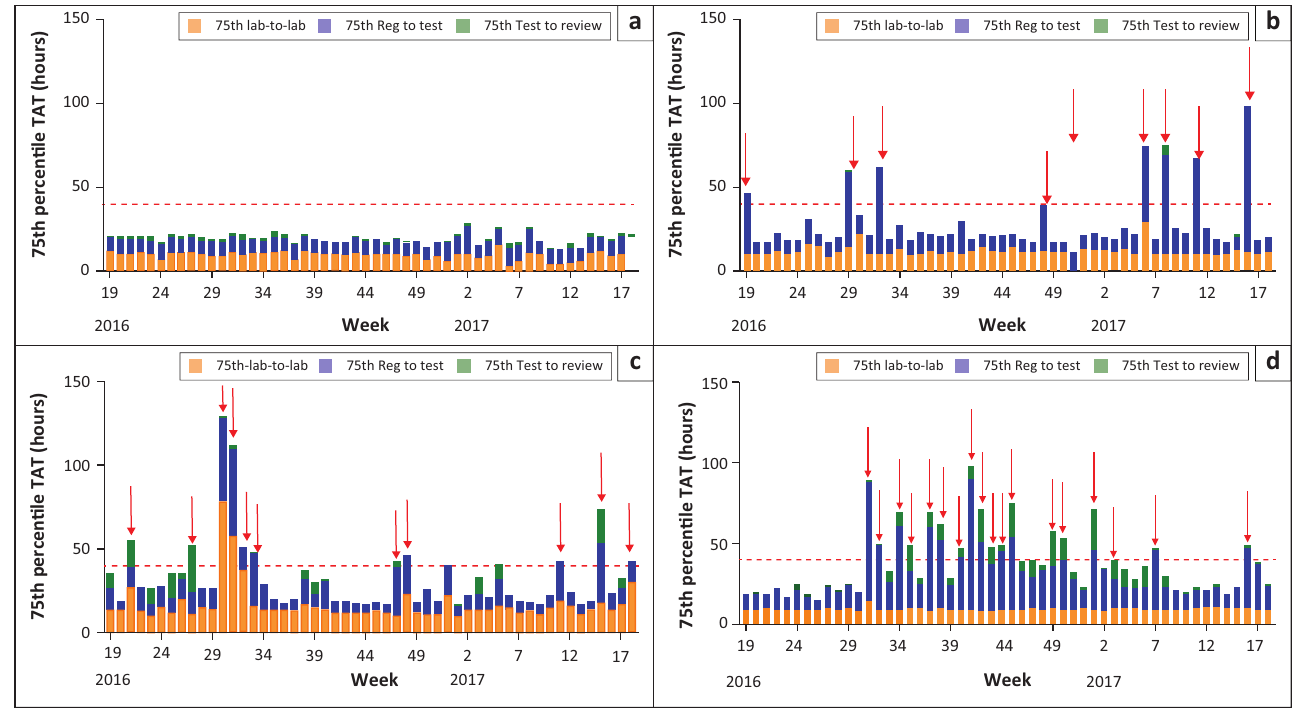
FIGURE 3: Scatter plots of the 75th percentile total turnaround time of individual laboratories in the National Health Laboratory Service within the provincial performance classification groups A to D for the 2016/2017 financial year. The overall 75th percentile total turn-around time per laboratory is indicated above each plot. (a) good performance ( n = 13 laboratories); (b) satisfactory performance ( n = 24 laboratories), (c) moderate to poor performance ( n = 5 laboratories), and (d) markedly poor performance ( n = 4 laboratories). High-volume (blue circles), medium volume (light blue squares) and low-volume (pink triangles) laboratories are indicated. The red line in each graphs represents the individual median total TAT values per